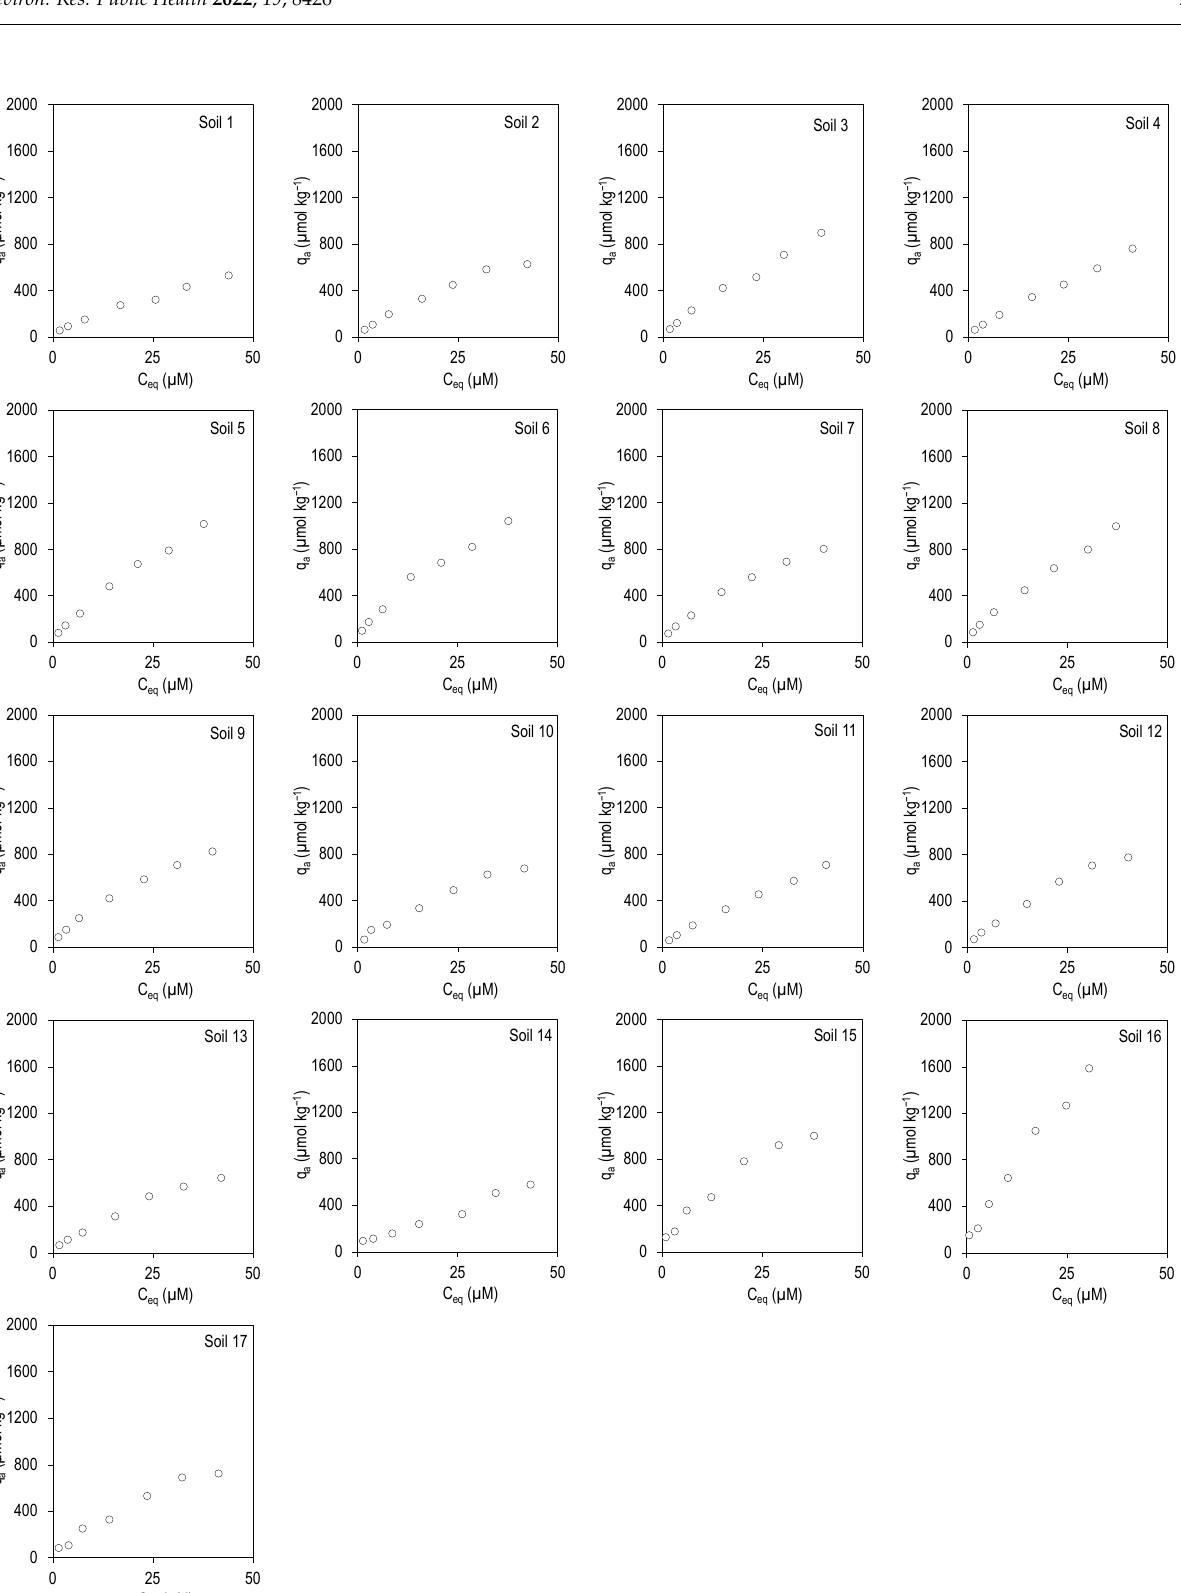
Figure 2. Adsorption curves for TRI in the 17 soils studied. q a : TRI adsorbed onto the soil; C eq : TRI concentration in the equilibrium solution. Average values ( n = 3), with coefficients of variation always lower than 5%.